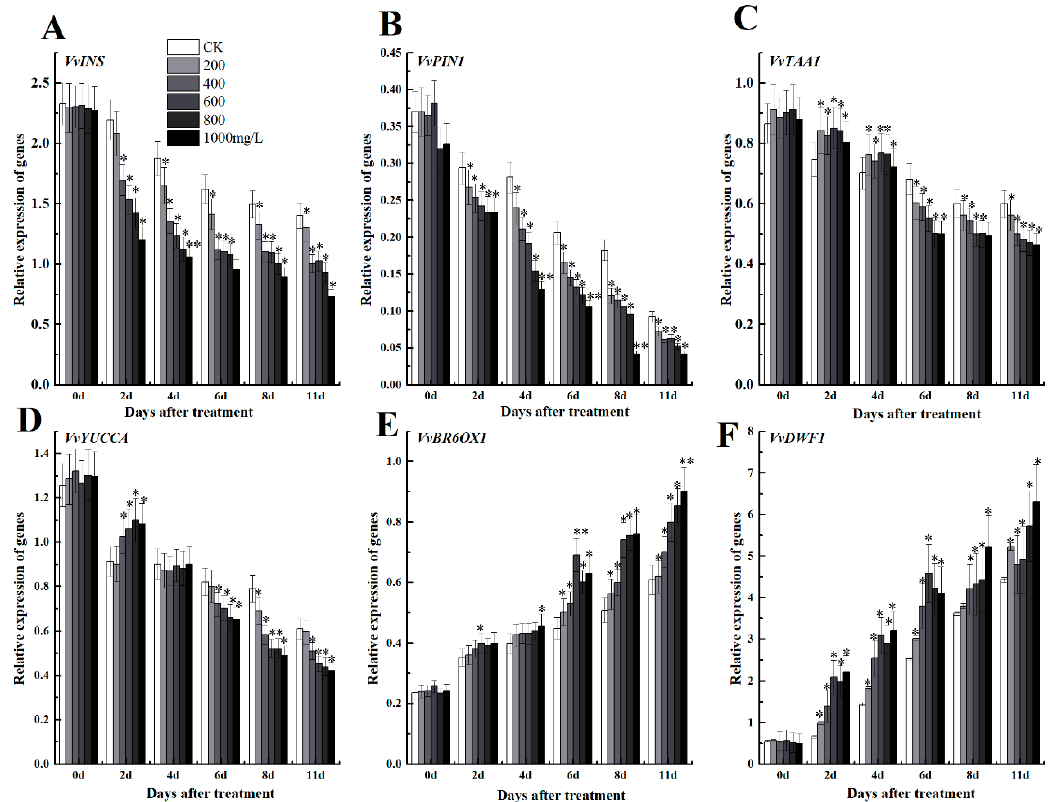
Figure 7. Effect of ethephon on auxin metabolism-related gene expression levels of ( A ) VvINS1 , ( B ) VvPIN1 , ( C ) VvTAA1 and ( D ) VvYUCCA . Brassinolide metabolism-related gene expression levels of ( E ) VvBR6OX1 and ( F ) VvDWF1 . Ethephon was used in different concentrations (200, 400, 600, 800, and 1000 mg/L) and in time course experiments (2, 4, 6, 8, and 11 days). Values are means ± SD of five biological replicates. * Significant differences compared with the control (water-treated fruits) sample at p < 0.05, ** Significant differences compared with the control (water-treated fruits) sample at p < 0.01 using Student’s test.